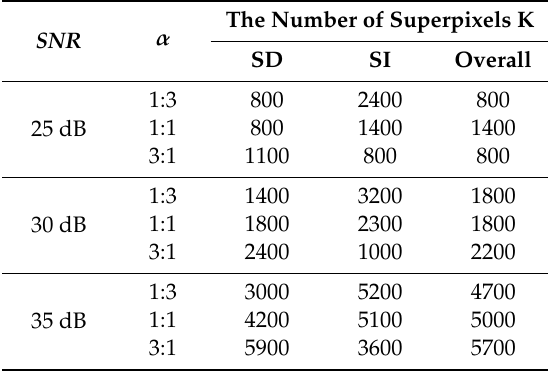
Table 4. The number of superpixels K of the optimal relative error for the superpixel-based MLRLS. The Number of Superpixels SNR α